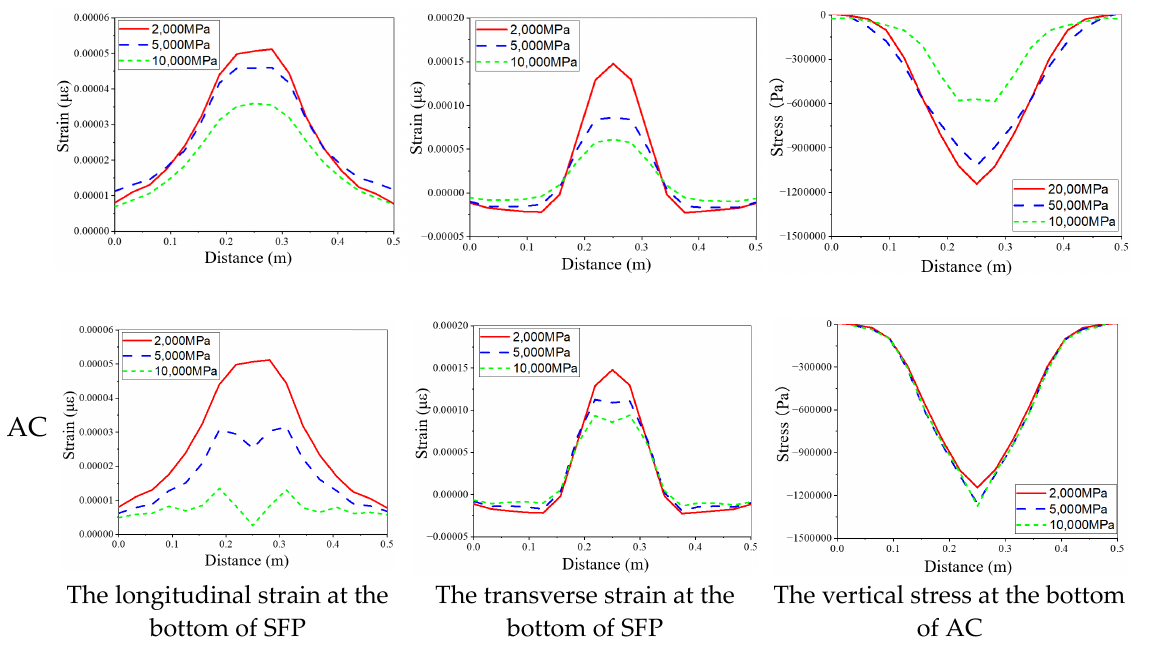
Figure 17. The effects of materials modulus on the dynamic responses of ART pavement.